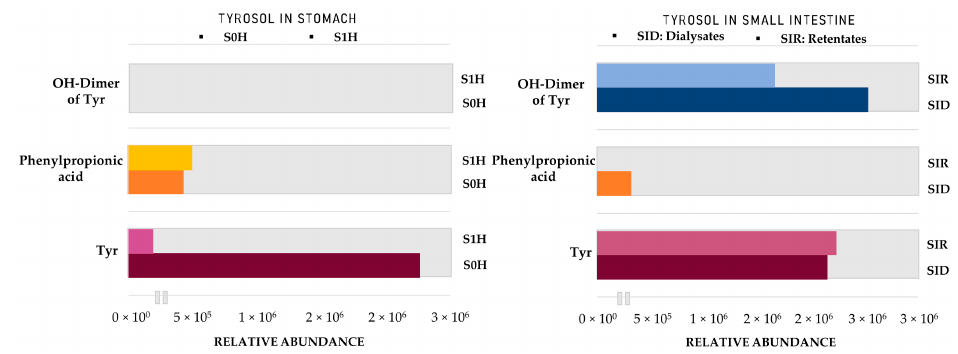
Figure 9. Area of Tyr metabolites in Stomach and Small Intestine. S0H : Stomach T = 0 h; S1H : Stomach T = 1 h; SIR : Small intestine retentates, T = 1.5 h; SID : Small intestine dialysates, T = 1.5 h. Tyr : Tyrosol; OH − Dimer of Tyr : Hydroxylated dimer of Tyr ( Tyr8 ).